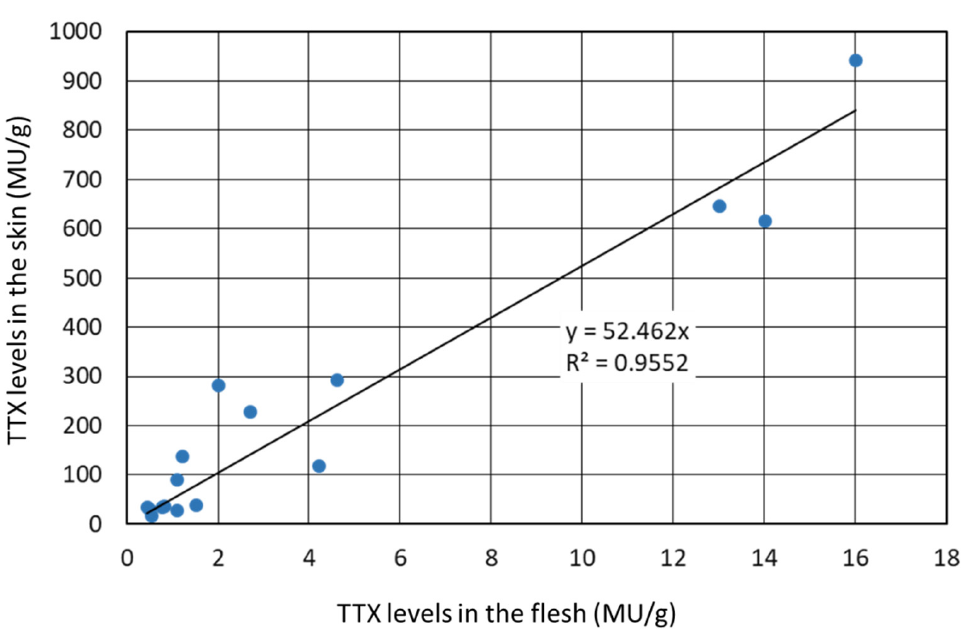
Figure 8. Relationship between levels in the flesh and the skin of the pufferfish, Takifugu flavipterus , when specimens were freeze–thawed before cutting into each tissue.